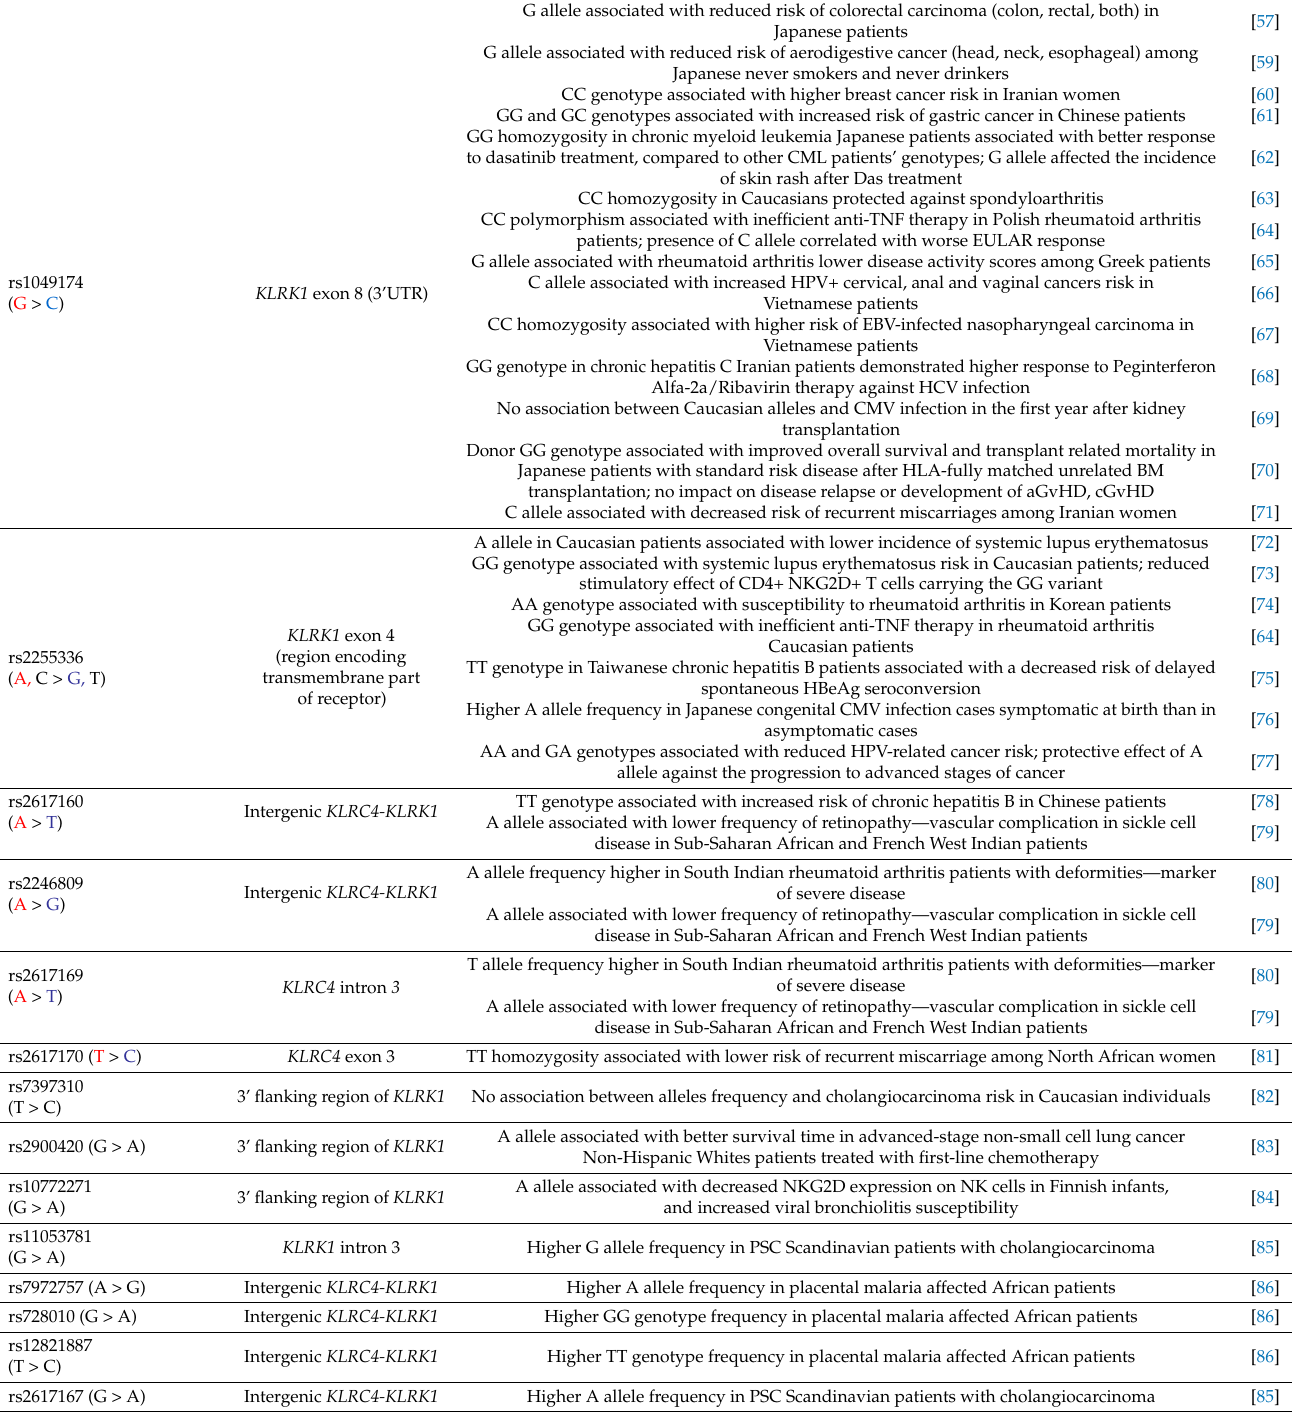
Table 2. Summary of reported relationships between single nucleotide polymorphisms located in the NKG2D gene and the rest of NKC region, and immunogenetic susceptibility to specific types of cancer, autoimmune, viral-induced diseases, and other disorders. Red/blue alleles presentation correspond to the HNK1, HNK2/LNK1, LNK2 haplotype SNP substitution, respectively. SNP ID Localization [58] Main Findings/Associations